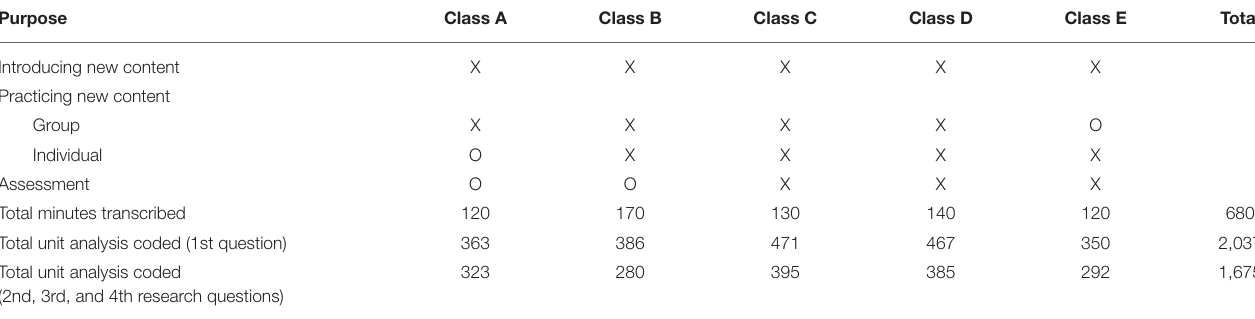
TABLE 3 | Types of lesson purpose for each class in the selected